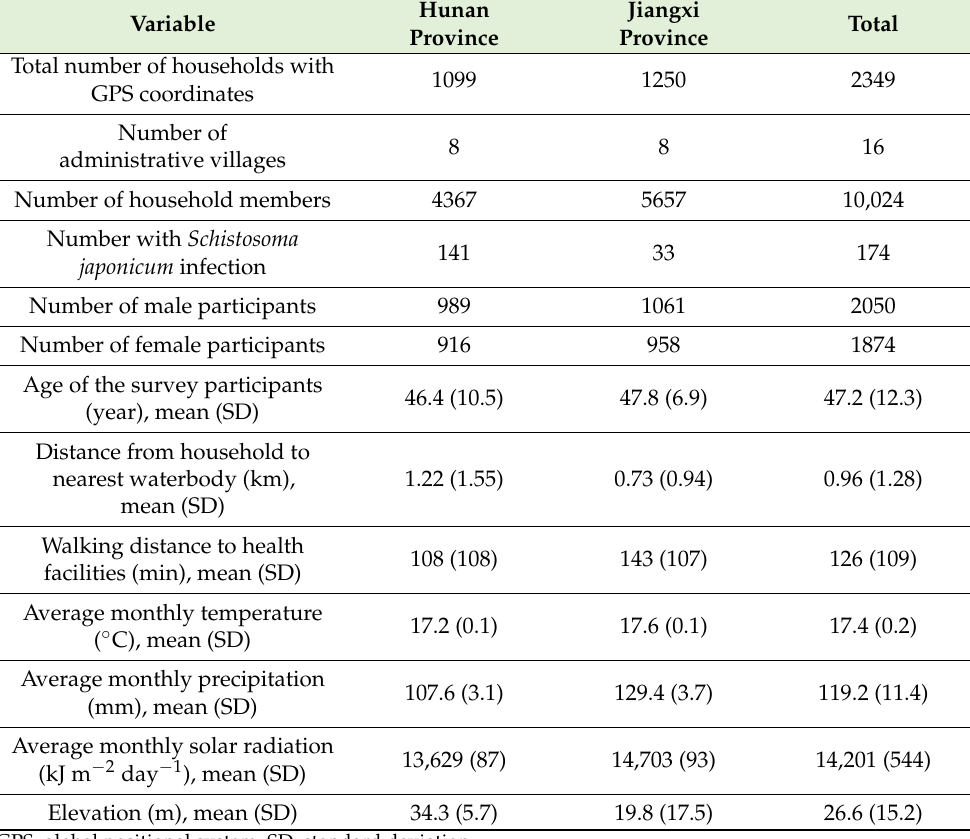
Table 1. Characteristics of the variables included in the study in Hunan and Jiangxi Provinces, People’s Republic of